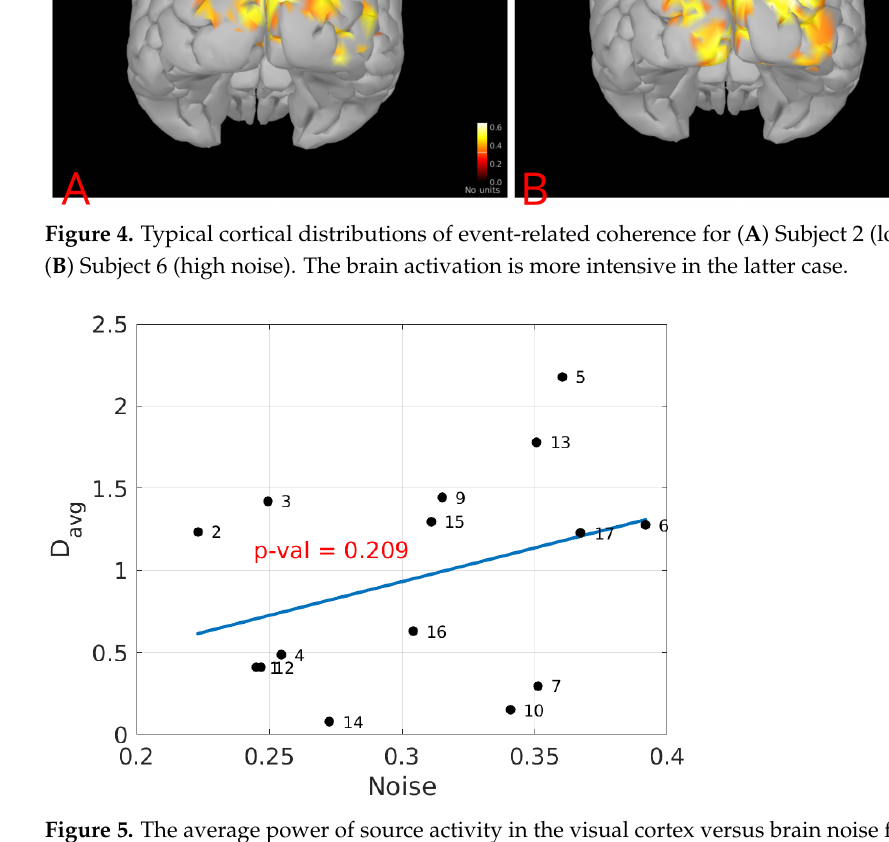
Figure 5. The average power of source activity in the visual cortex versus brain noise for all subjects (numbers denote the subjects). The line is a linear approximation fit ( p = 0.209, R 2 =